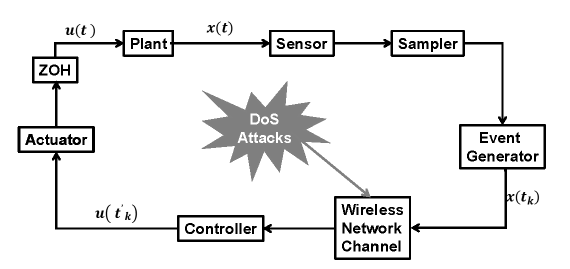
Figure 1. Schematic representation of dynamic event-triggered control for nonlinear systems under DoS attacks.